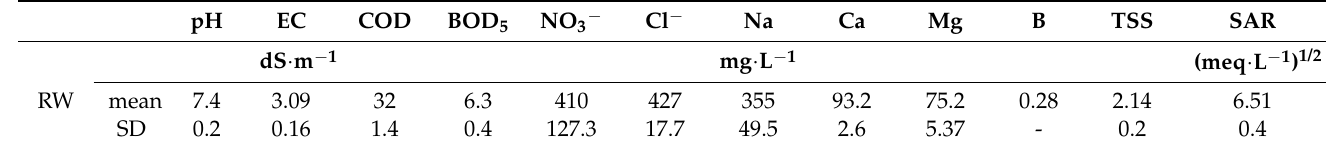
Table 2. Chemical parameters analyzed in reclaimed water, RW.